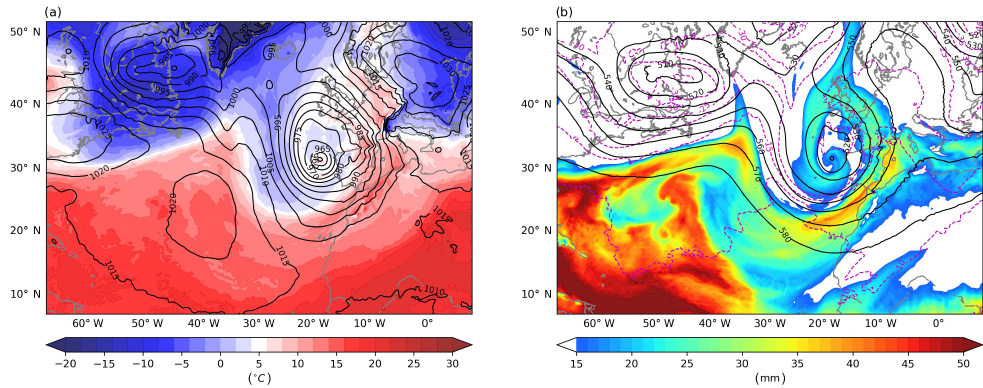
Figure 8. Similar to Fig. 3, but for 7 November 1982 at 12:00UTC.